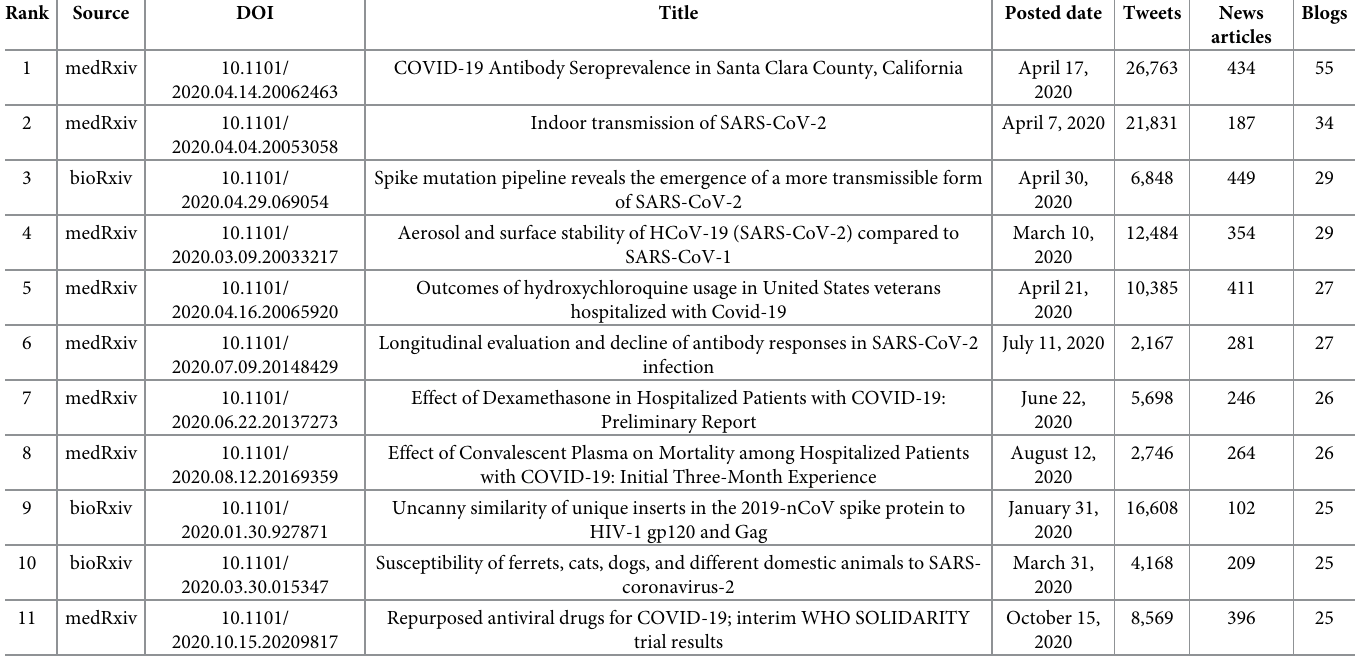
Table 5. Top 10 most blogged COVID-19